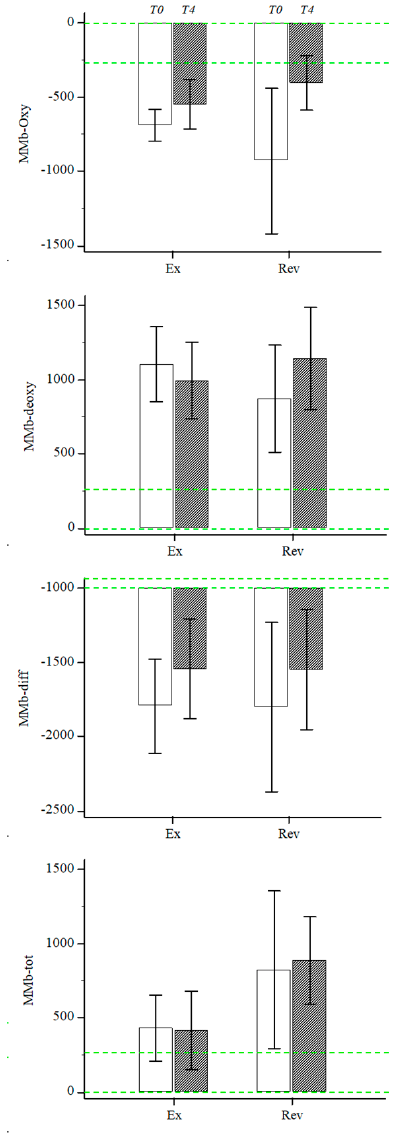
Figure 2. Muscle metabolic biomarkers for the two groups obtained at baseline (white column) and after 4 months (gray column). Green line represent the reference values in a healthy population previously tested [25]. Data are expressed as mean and standard error of mean. Rev: revascularization; Ex: exercise; T0: baseline; T4: 4 months.